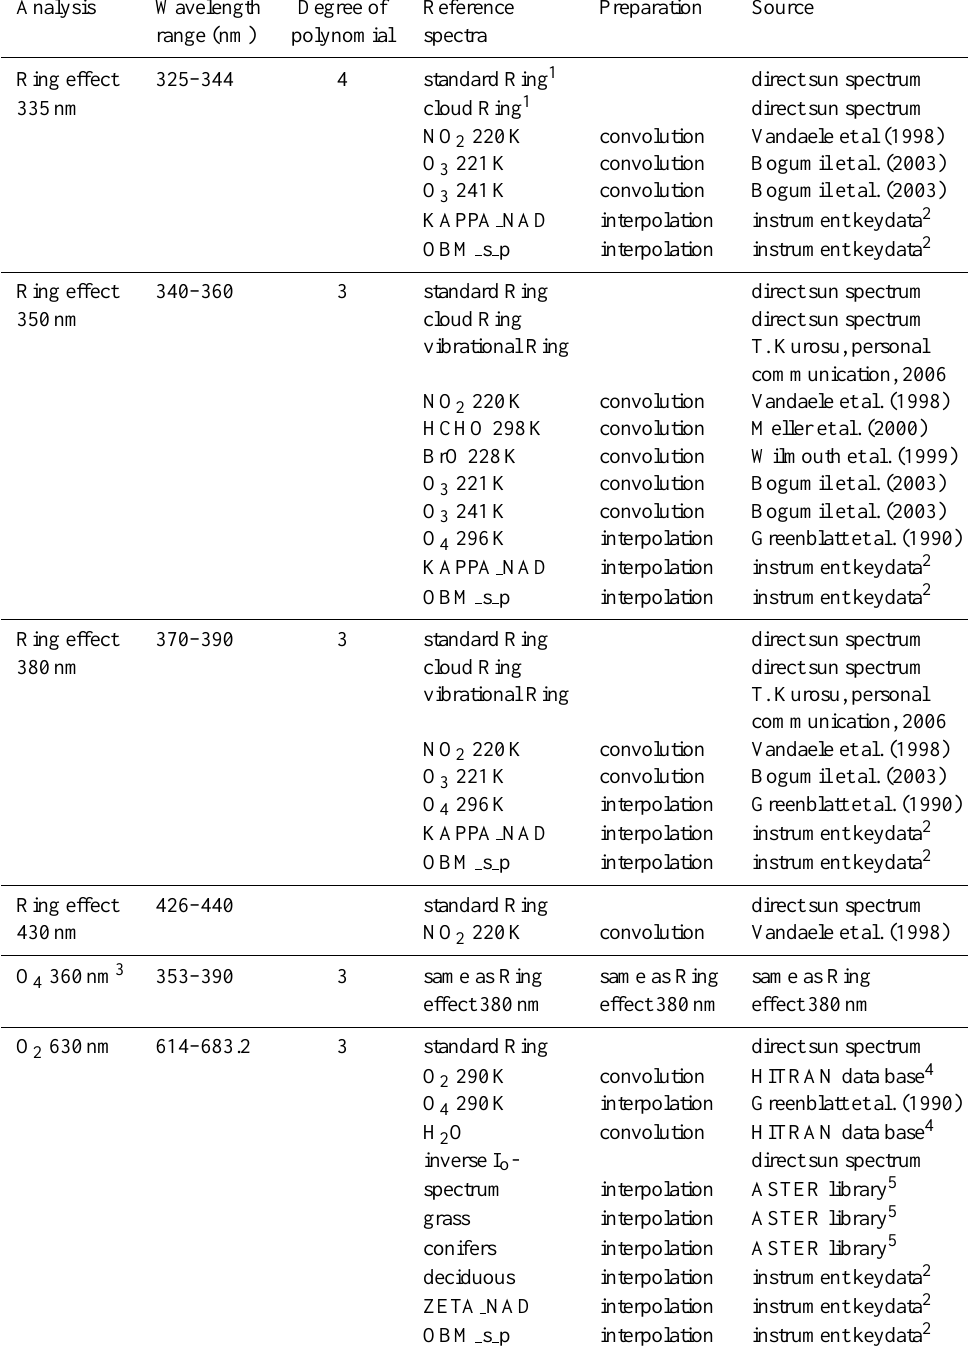
Table 1. Overview on the selected parameters for the different spectral